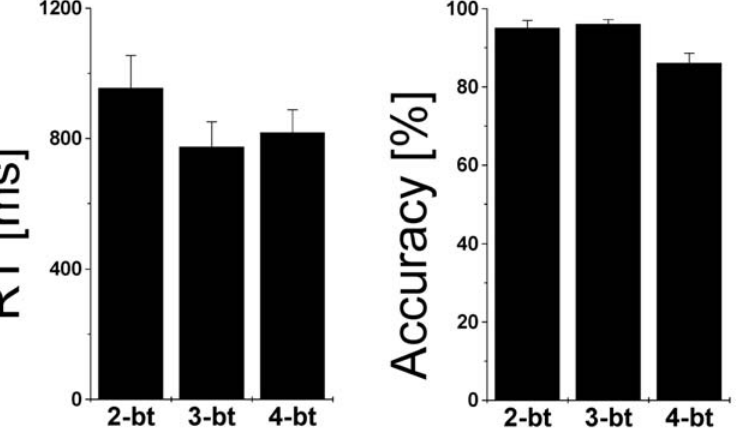
Figure 3. Performance accuracy and reaction time during the parametric VA fMRI task. Accuracy was significantly lower during 4-ball tracking task than during 2- and 3-ball tracking tasks, reflecting the increased difficulty of the task. Values represent means 6 standard deviations across 14 healthy men. doi:10.1371/journal.pone.0006102.g003 PLoS ONE |